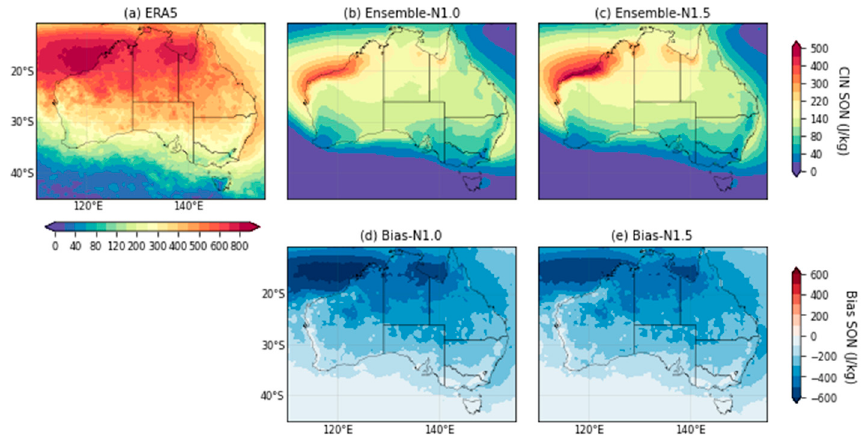
Figure A7. Climatology of CIN in d01 from ( a ) ERA5, ( b ) N1.0 and ( c ) N1.5 during SON. ( d , e ) are the